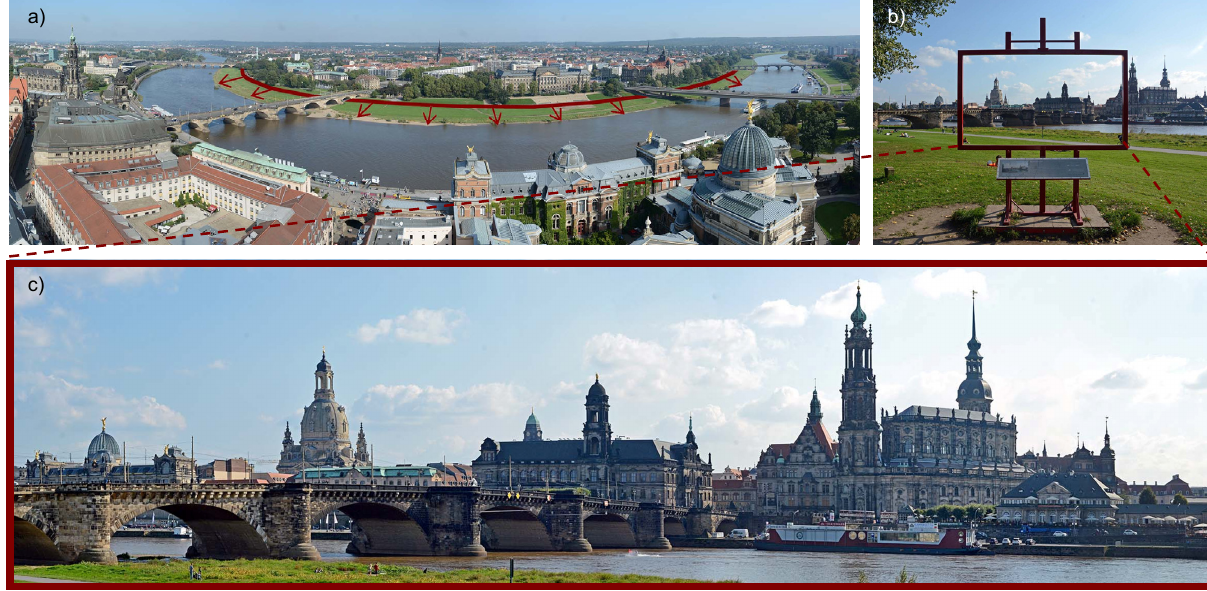
Figure 3. Panorama of Dresden from river side, exposing most important historical elements of city landscape: a) view from Frauenkirche roof on pedestrian area long river; b) observation point in form of easel referring to painting by Canaletto